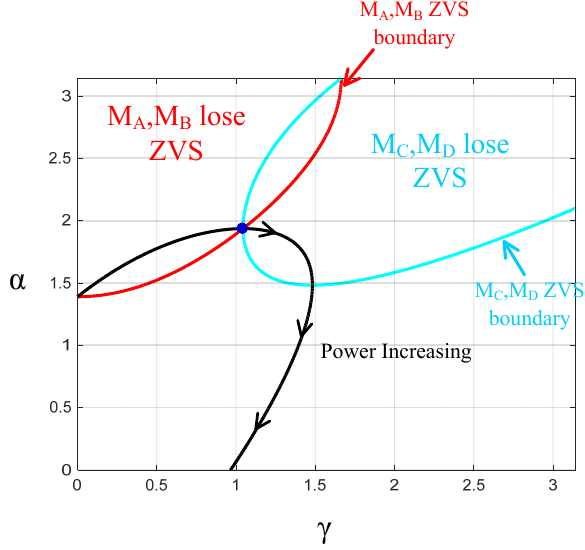
Figure 5. The ZVS operation regions for the trajectory of the power